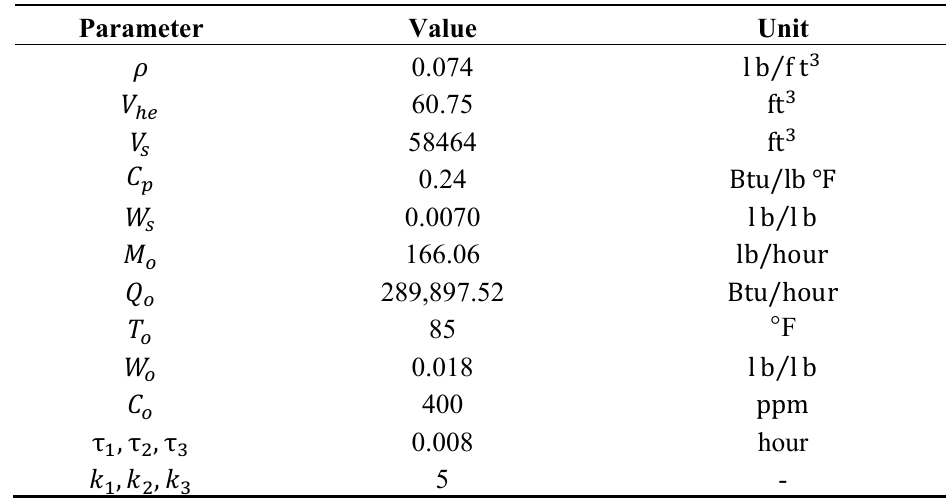
Table 1. Numerical values for system parameters.